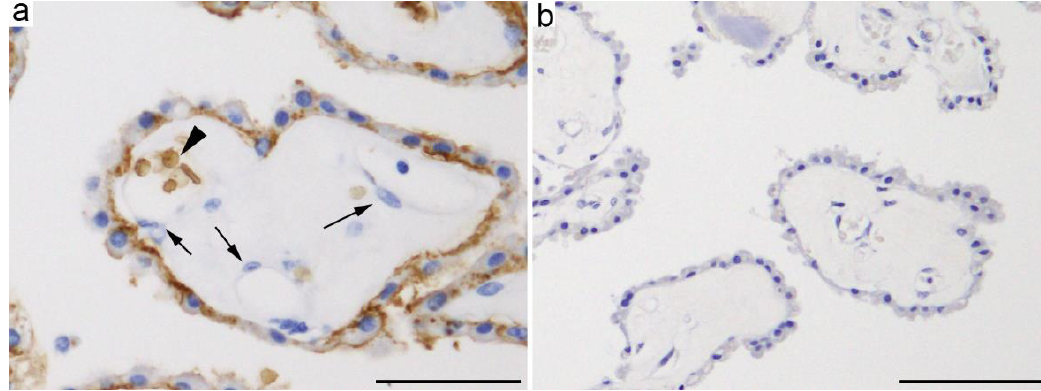
Figure 1. Representative microphotographs of immunohistochemical staining for ( a ) GLUT1 (clone SP168, ab150299, Abcam, Cambridge, UK, 1:200, antigen retrieval with citrate buffer (pH 6)) and ( b ) GLUT12 (bs-2540R, Bioss, Boston, MA, USA) [28] in human choroid plexus (CP). ( a ) GLUT1 is mainly located in the basolateral membrane of CP epithelial cells, whereas no GLUT1 is detected in capillary endothelial cells of the CP parenchyma (arrows). Erythrocytes in the capillary show high GLUT1 expression (arrowhead). ( b ) No apparent GLUT12 immunoreactivity is observed in CP epithelial cells. Scale bars: 50 μm.